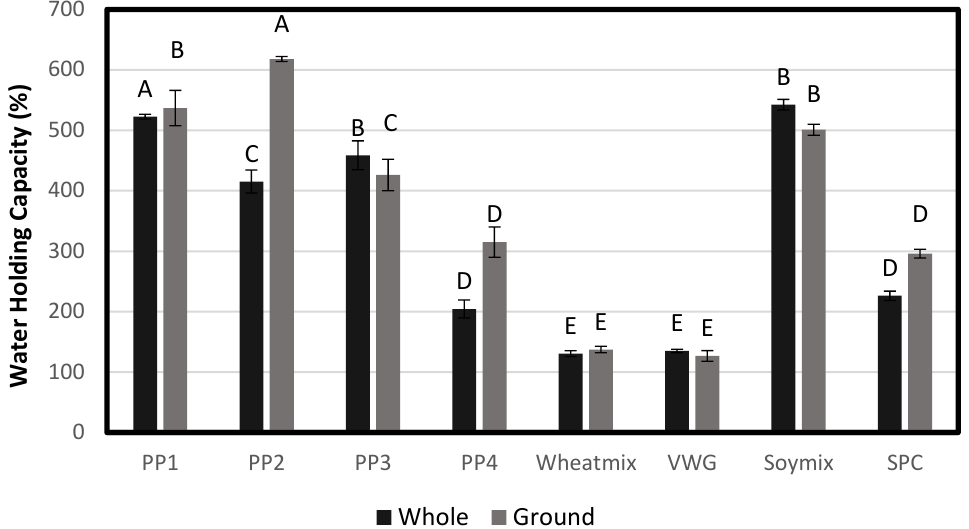
Figure 14. Water holding capacity (%) of whole extrudates and ground extrudates. Bars denoted by the same letter are not significantly different ( p < 0.05).